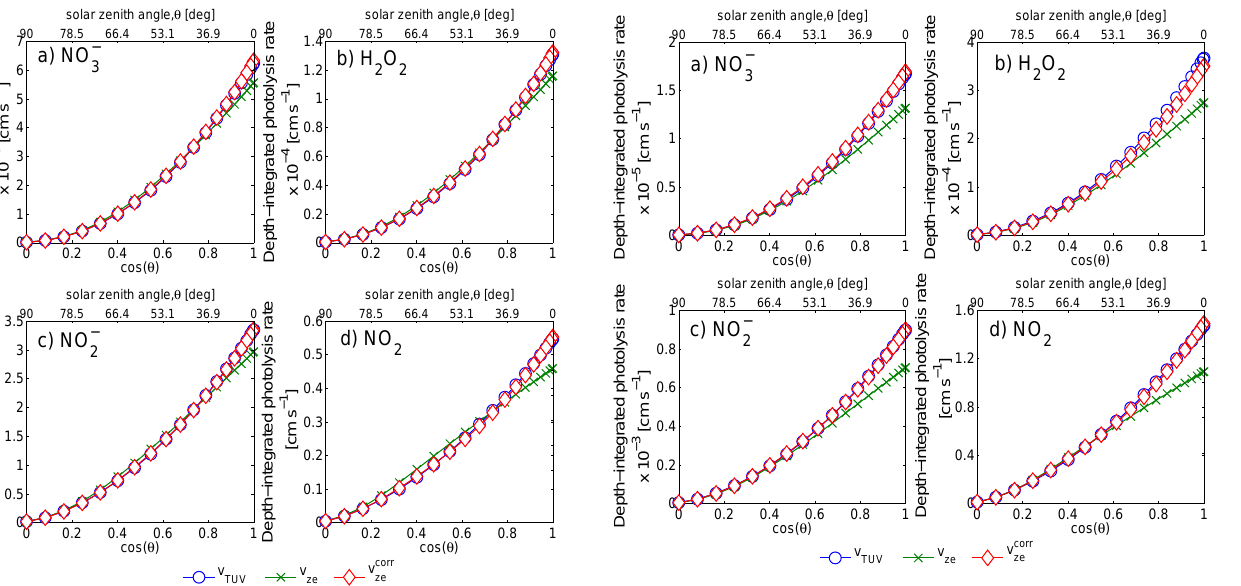
3 anion; 2 , calculated by the e , corrected v z by e e